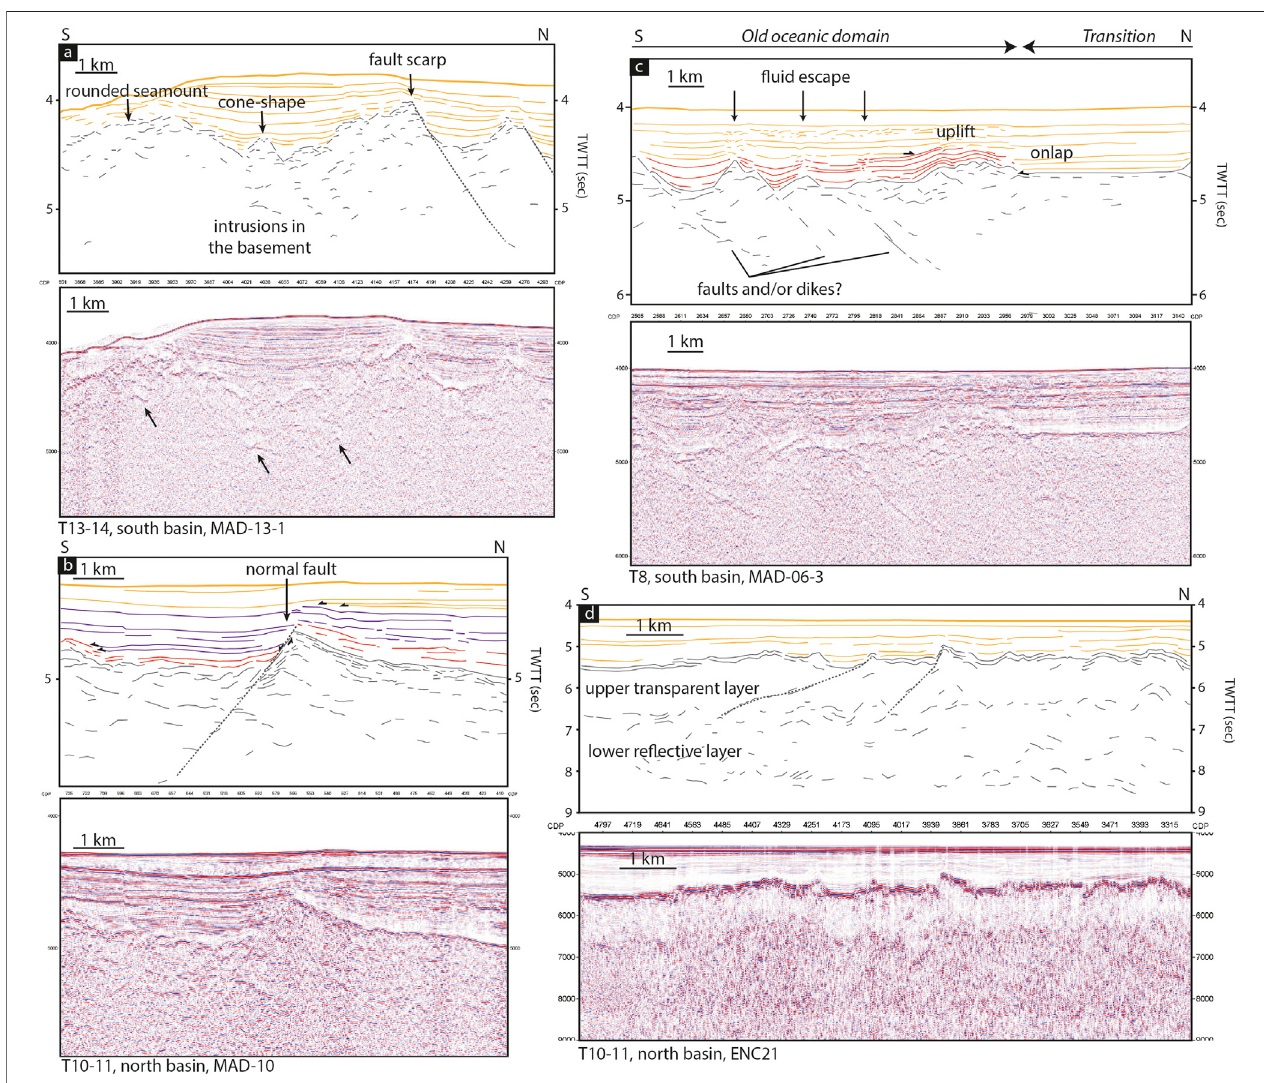
FIGURE7| Exampleoftopbasement morphologyintheold oceanicdomain. (A) Closeupalongthe seismictransectT13 – 14, southbasin. (B) Close upalongthe seismic transect T10 – 11, north basin. Orange sediments represent undeformed sedimentary unit onlaping on oldest (red and violet) units showing syn- or post- depositiondeformation. (C) DetailsofthecontactbetweentheoldoceanicdomainandthesmoothandregularbasementsubdomainalongthetransectT8,southbasin. Note the difference in top basement morphology and the onlap of the smooth and regular basement subdomain onto the old oceanic crust. This fi gure shows deformation insediments(in red) and thepresence ofdeformed sediments incolumns ending onlarge-scalehorizontal lenses ofhighly perturbed sediments. (D) Details oftheoldoceaniccrustalonganENCENSseismicline.The fi gureshowstheuppertransparentlayerof1 s(twtt)thickandthelowermore re fl ectivelayer.Location ofthe close-up views is shown in Figure 6